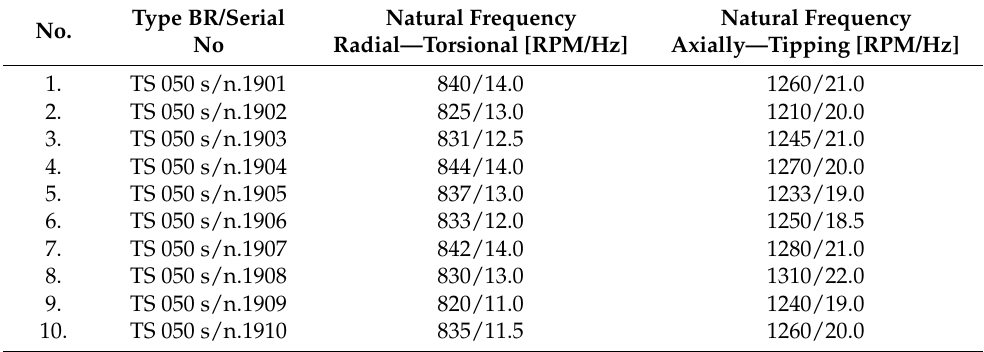
Table 4. Values of natural BR TS 050 frequencies measured after the trial run (configuration A).